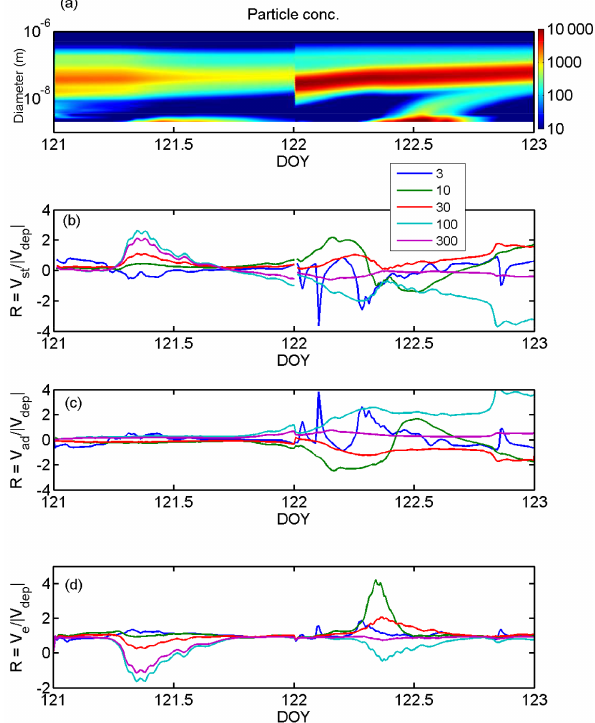
Figure 8. (a) Particle size spectrum and the change velocities (pre- sented as the ratios to the absolute value of the deposition term) for selected particle sizes for (b) storage, (c) aerosol dynamics and (d) vertical exchange during 1 and 2 May (DOY 121 and 122)